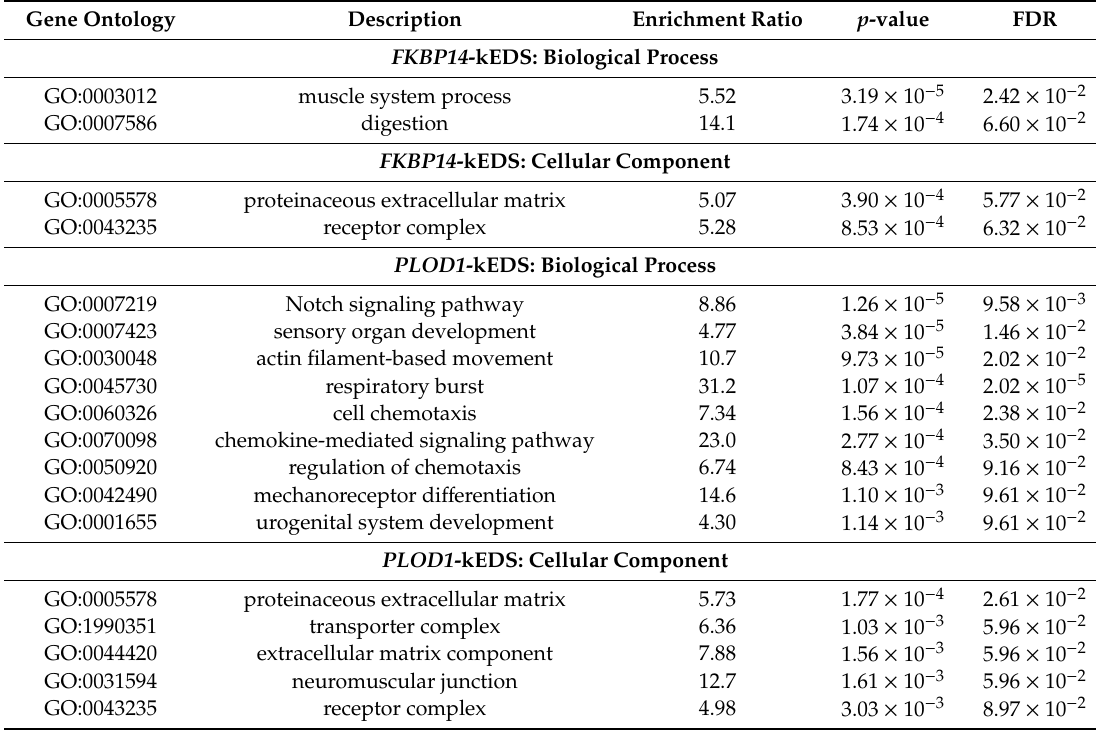
Table 3. Over-represented gene ontology terms among DEGs in FKBP14 -kEDS and PLOD1 -kEDS patient-derived fibroblasts versus